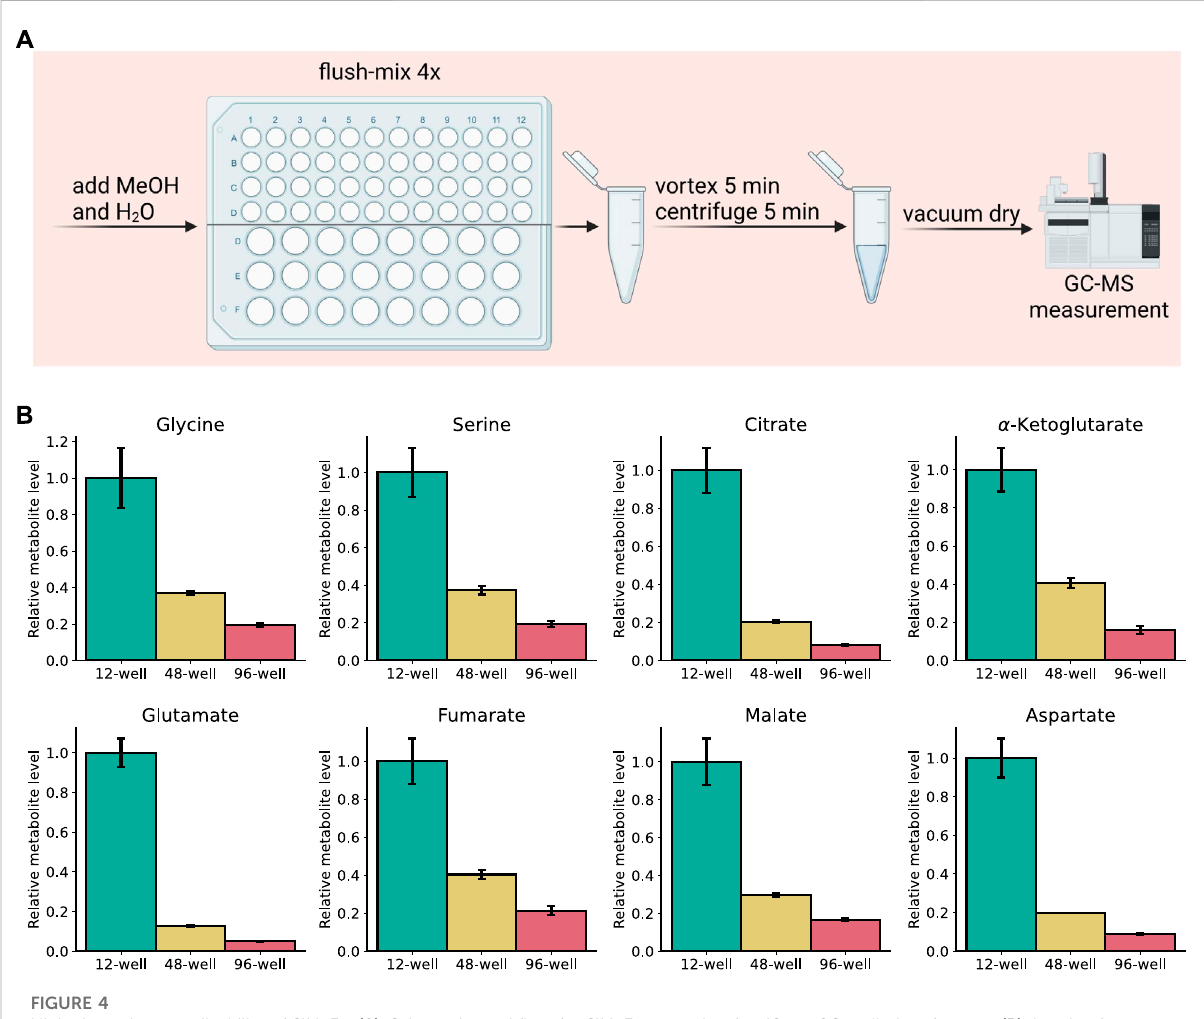
FIGURE 4 High-throughput applicability of SiMeEx. (A) . Schematic work fl ow for SiMeEx extraction for 48- or 96-well plate formats. (B) . Levels of representative metabolites extracted from RAW 264.7 cells cultured on different formats of multi-well plates. All data are normalized to metabolite levels of 12-well plate and presented as mean ± SEM calculated from three independent experiments with n = 3 technical